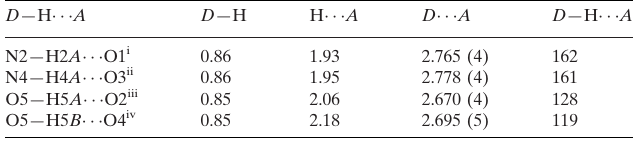
Hydrogen-bond geometry (A˚ , (cid:2) ).